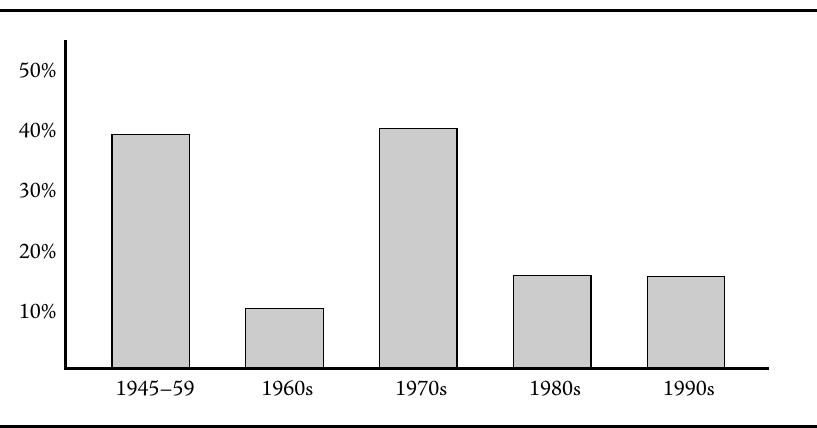
Source: Analysis of the data from the Minorities at Risk Project reported in Gurr (1994: Table 1). Ethnopolitical conflict is defined as political rioting, local rebellions, guerrilla activity, given decade. Groups are counted only once in any given decade.Violence initiated in a previous decade is not counted as a violence in the next